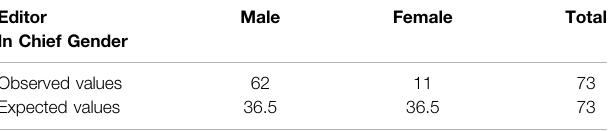
TABLE 2 | Total observed and expected values by gender of editor(s)-in-chief.